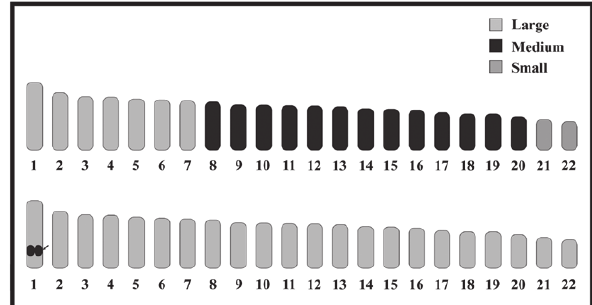
Figure 4. Standardized idiogram showing lengths and shapes of chromosomes of Rhinecanthus aculeatus (2 n =44) by conventional staining and Ag-NOR banding techniques. The arrow indicates nucleolarnucleolar organizer